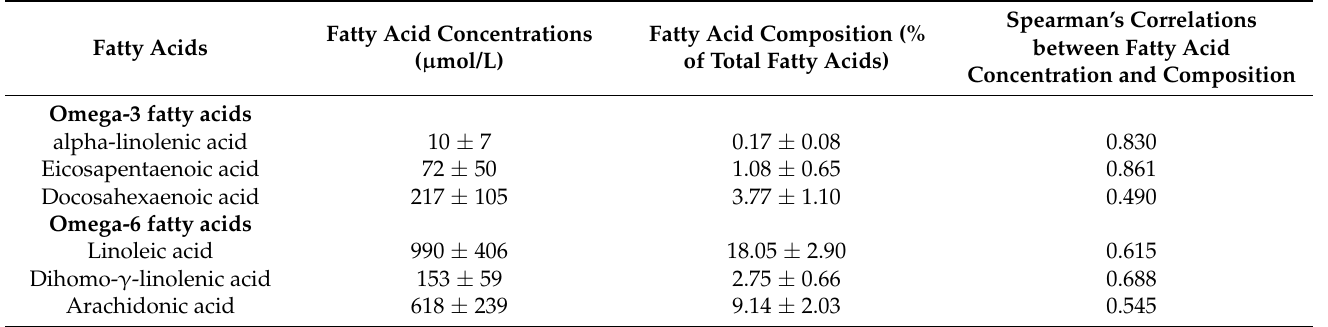
Table 2. Omega-3 and omega-6 fatty acids measured in serum phospholipids ( n = 1264).